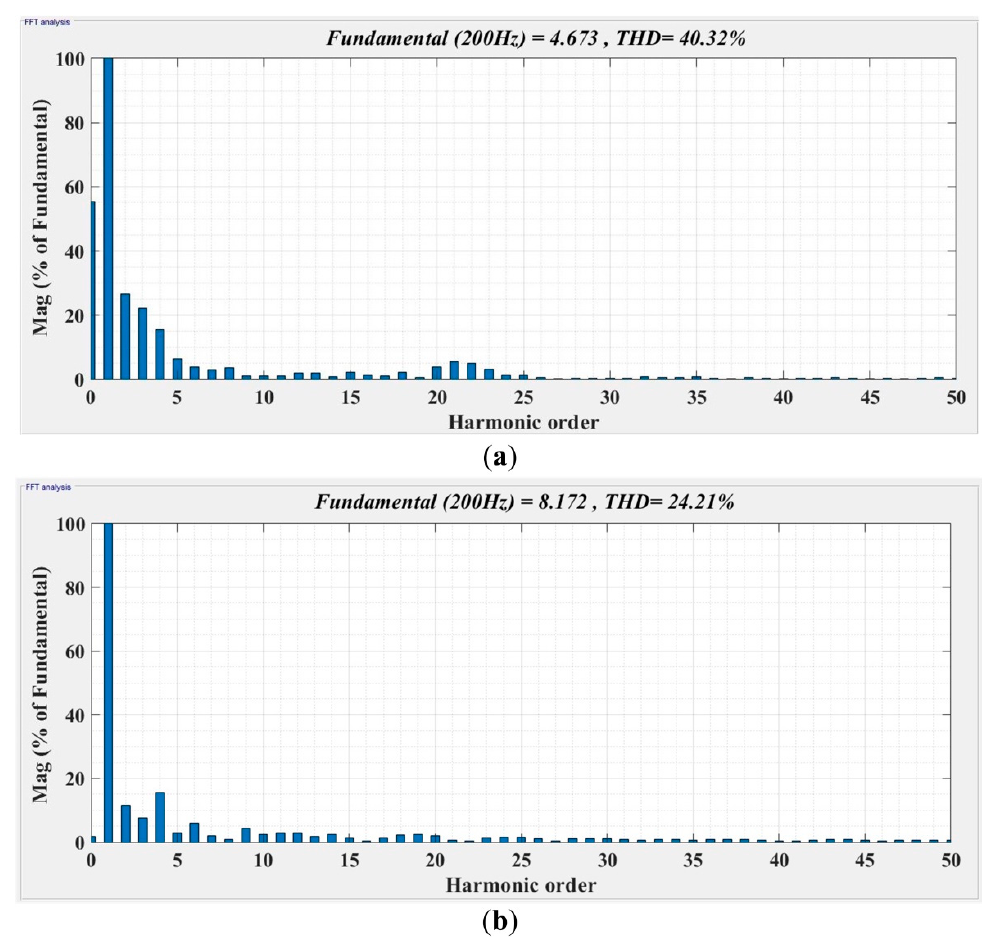
Figure 47. Comparative FFT and THD analysis: ( a ) with PI-PSO controller; ( b ) with backstepping controller.